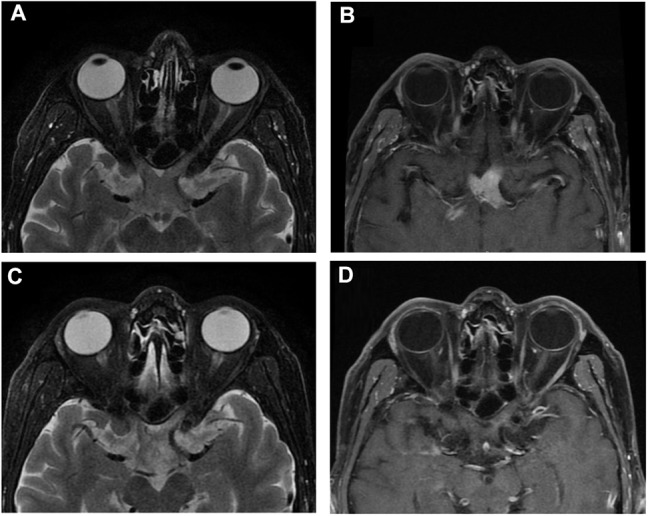
Orbital MRI of Case 1. (A,B) Orbital MRI showed chiasm enlargement in T2-weight imaging and its intrinsic homogenous enhancement of the optic chiasm in T1-weight enhanced imaging when the patient first visited the clinic. (C,D) MRI showed moderate enlargement in T2-weight imaging with a light intrinsic enhancement in T1-weight imaging of the optic chiasm after steroid treatment.